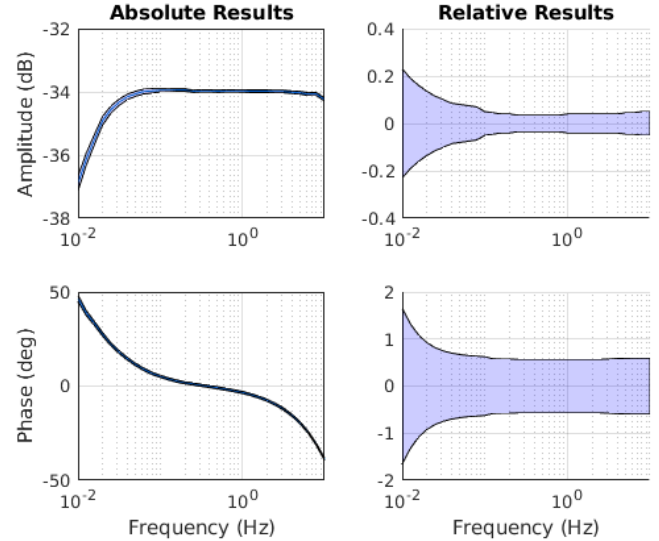
Figure 5. MB2005 response curves. The top panels show the amplitude response (in dB V/Pa) and the bottom panels shows the phase (degrees). The left panels show the absolute results, and the right panels show deviations relative to the average results. The average response is the blue line with the expanded uncertainty being the shaded